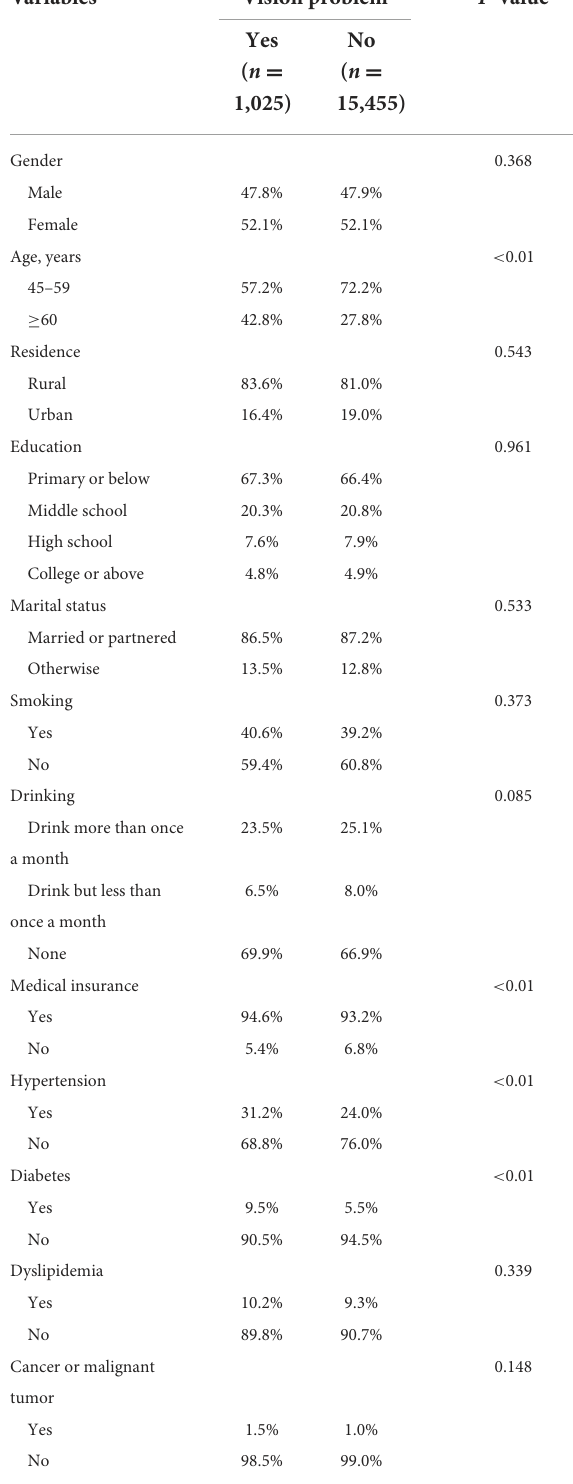
TABLE 1 Characteristics of the respondents by visual impairment in cross-sectional study (values are the weighted percentage of vision